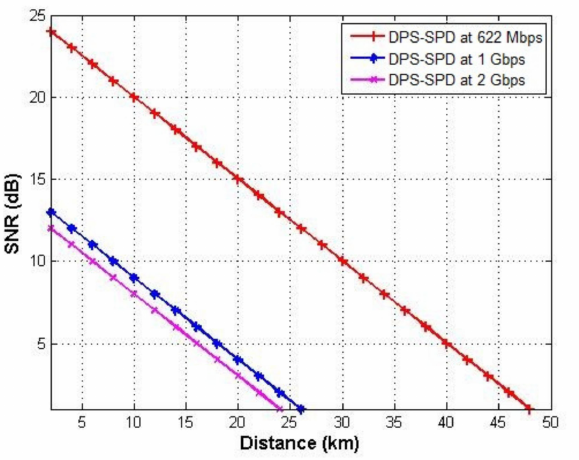
Figure 12. SNR versus transmission distance for DPS code using SPD detection scheme at 622 Mbps, 1 Gbps, and 2